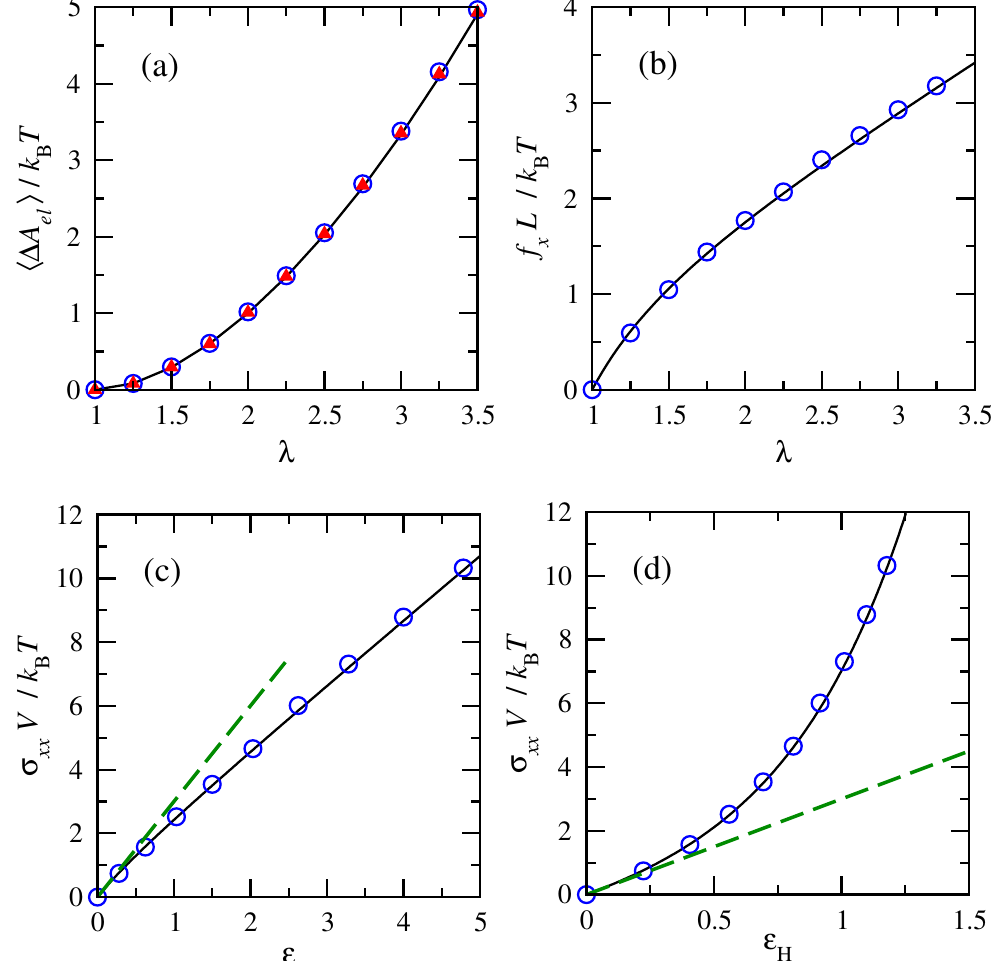
Figure 2. Analytical and numerical comparisons of ( a ) elastic free energy changes, ( b ) force in tension, and ( c ) stress in tension for ( ◦ , blue) trans- and ( (cid:78) , red) cis-1,4-polybutadiene chains of 50 repeat units at 343 K. The dashed line indicates the initial modulus. Hencky finite strain is employed in ( d ). Overlapping results for cis- are omitted in ( b – d